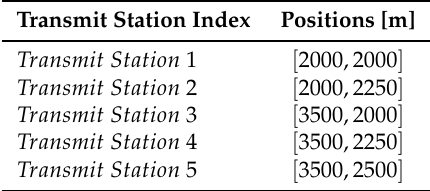
Table 1. Positions of the Transmit Stations.